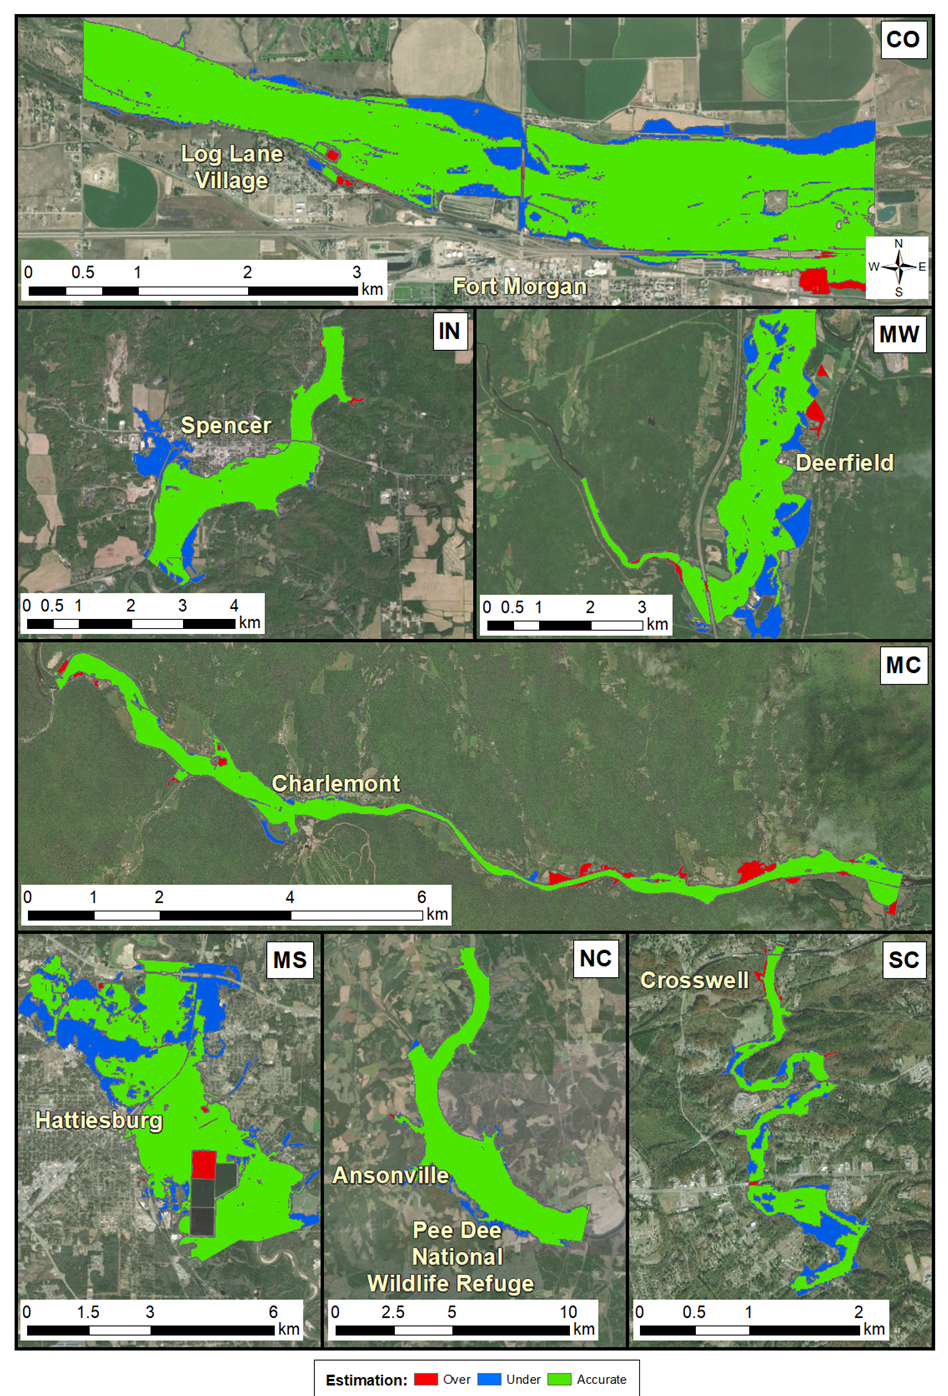
Figure 7. Flood map comparison between AutoRoute + ARPP simulations and USGS flood maps for high-flow events at the seven test sites. Areas shaded green (Accurate) indicate areas where AutoRoute + ARPP and the USGS flood maps agree. Areas shaded red (Over) indicate where only AutoRoute + ARPP simulates the area as flooded. Areas shaded blue (Under) indicate where only the USGS shows the area as flooded. Some of the overestimation in the MS model simulation occurs at water treatment ponds, which were not included in the USGS flood maps and can bias the results. Sources of the background imagery include ESRI, DigitalGlobe, Earthstar Geographics, CNES/Airbus DS, GeoEye, USDA FSA, USGS, Getmapping, Aerogrid, IGN, IGP, and the GIS user